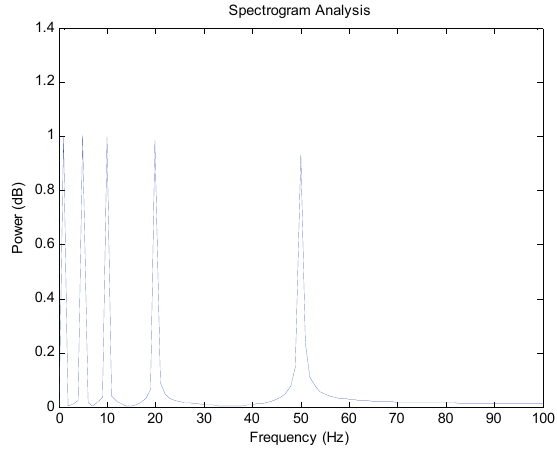
Figure 7. The spectrogram analysis of the error